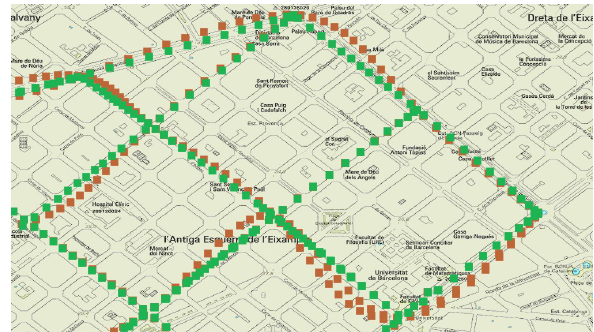
Figure 7. Simulated air quality maps of a neighbourhood of Barcelona obtained with the C-AQM system. Map of properly georeferenced but uncalibrated data.